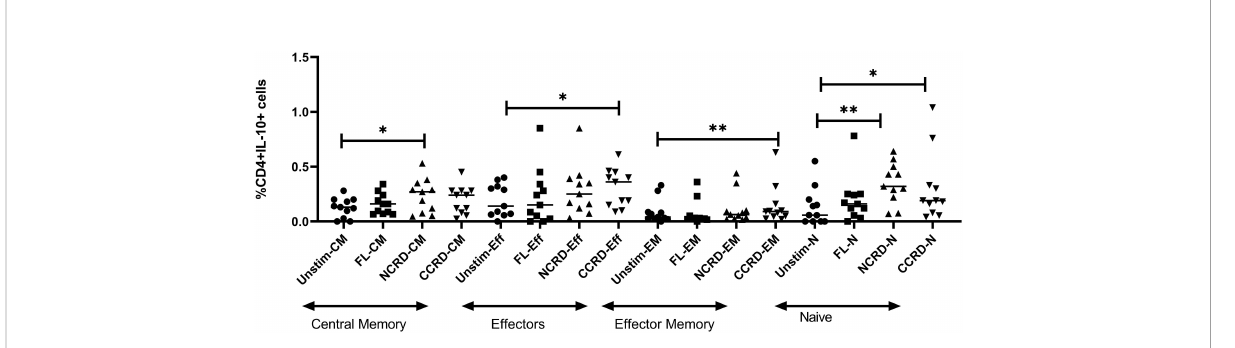
FIGURE 5 IL-10 expression by central memory, effector, effector memory, and naive CD4 identi fi ed based on CCR7 and CD45RA expression using intersecting gates after treatment with the full-length, N-CRD, and C-CRD Gal-9 proteins ( n = 11). The percentage of CD4 cells expressing IL- 10 is shown on the Y -axis, and different CD4 phenotypes and conditions used are shown on the X -axis. Individual values are plotted as scatter plots, and the horizontal line represents median values. p -values showing signi fi cant differences ( p < 0.05) between unstimulated and treated cells as calculated by the Wilcoxon signed-rank test are shown. *p < 0.05, **p < 0.01.